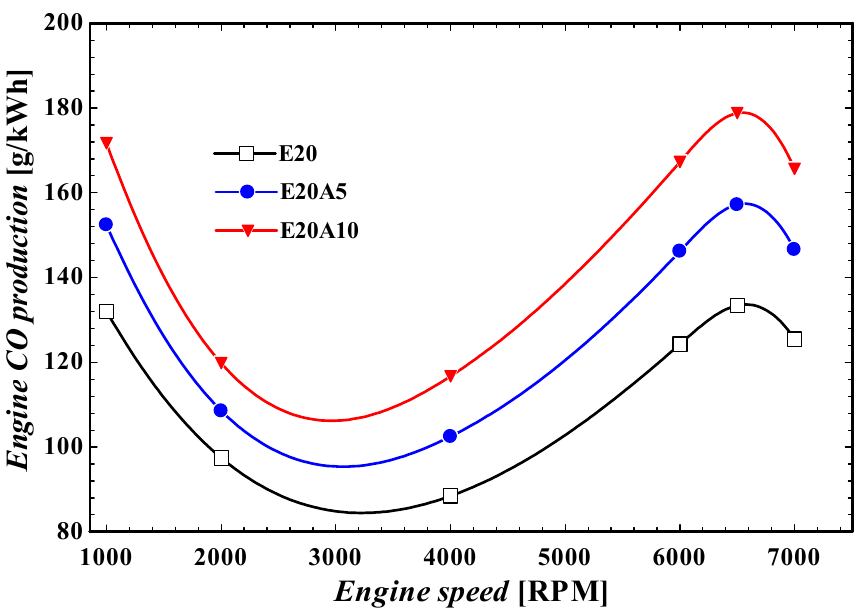
Figure 13. CO production at various engine speeds at different fractions of ammonia.